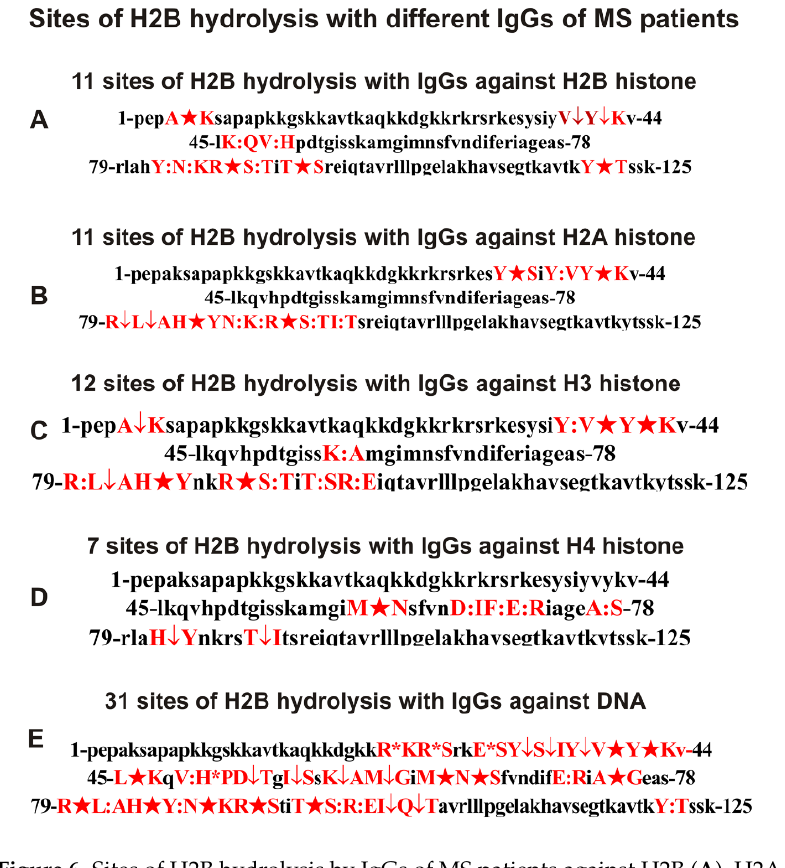
Figure 6. Sites of H2B hydrolysis by IgGs of MS patients against H2B ( A ), H2A ( B ), H3 ( C ), H4 ( D ), and DNA ( E ). Major sites of H2B cleavage are marked by big stars ( ★ ), moderate ones by arrows ( ↓ ), and minor sites of the splitting by colons (:) ( A – E ). Clusters and sites of histone hydrolysis are shown in red.